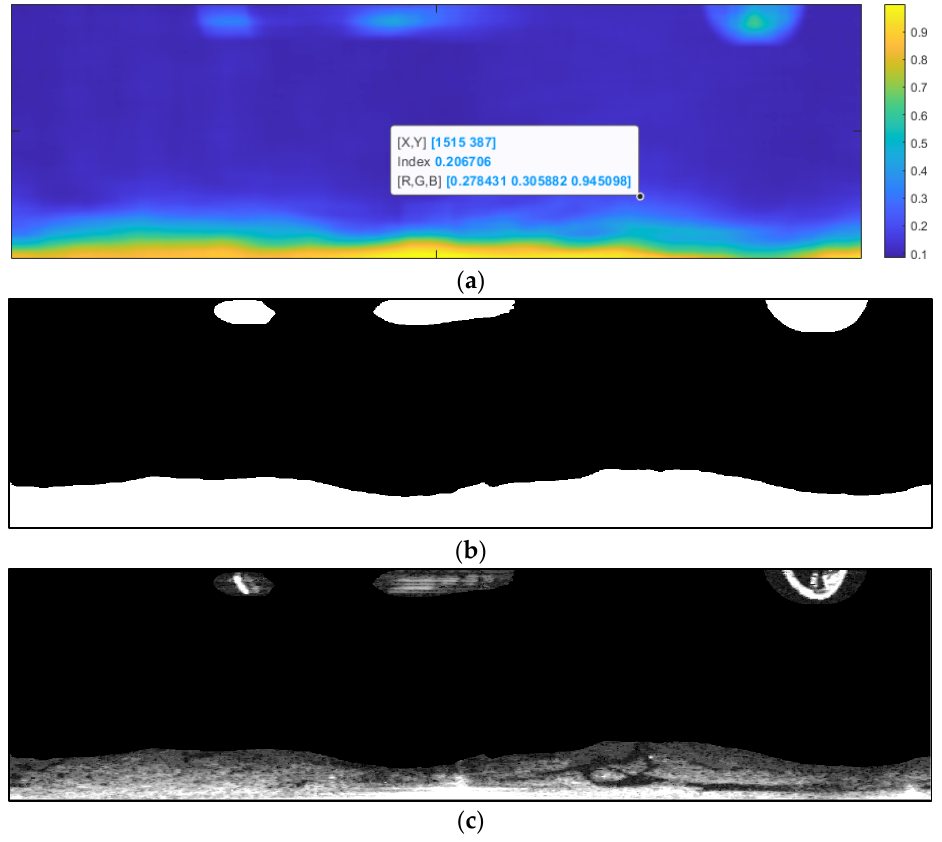
Figure 16. E ff ective monitoring regions extraction with gray distribution matrix. ( a ) Gray distribution matrix; ( b ) Threshold segmentation; ( c ) E ff ective monitoring region extraction.